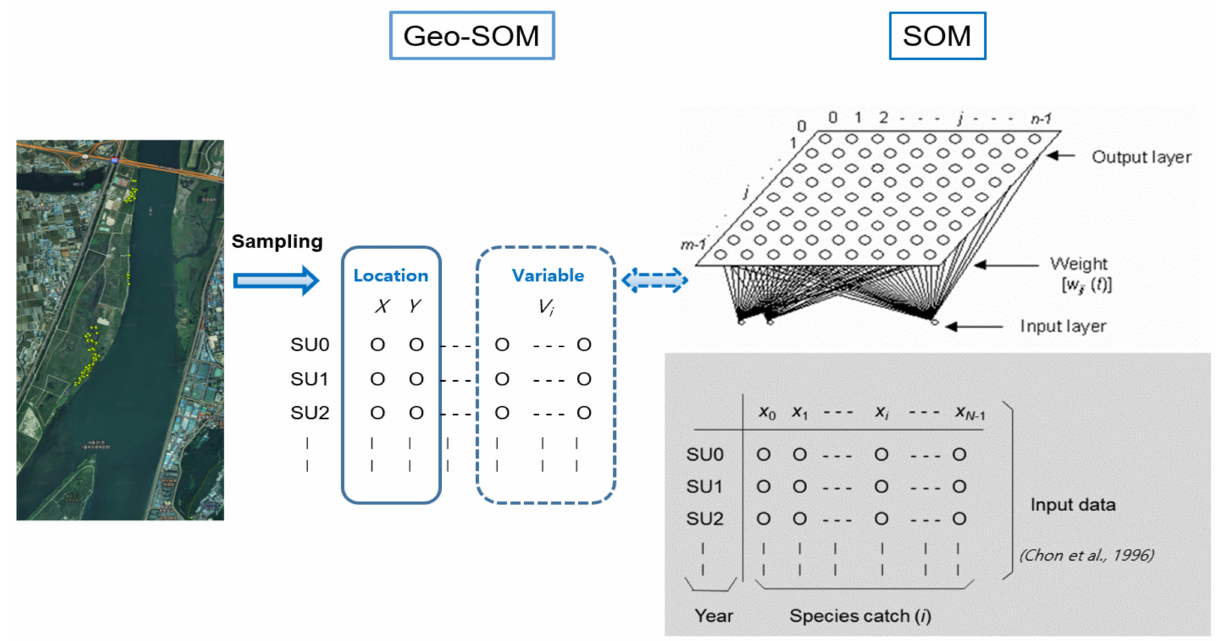
Figure 3. Geo-self-organizing map (Geo-SOM) applied to the patterning of associations among locations, environmental factors, and biological data for movements of nutria